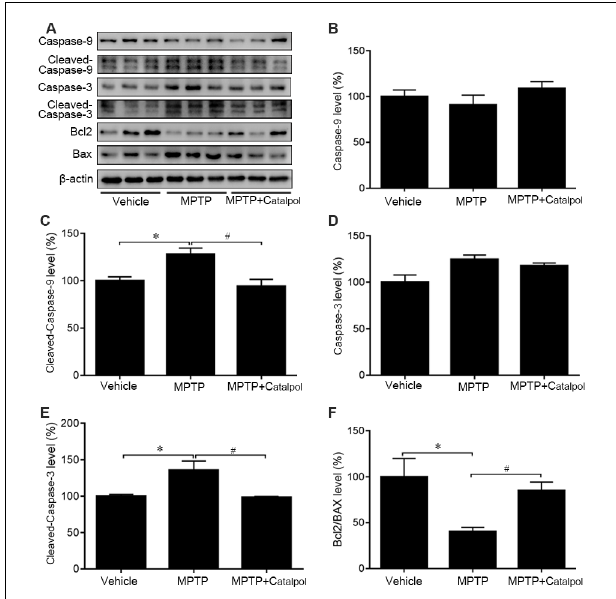
FIGURE 3 | Catalpol inhibits apoptosis in the SN of mice treated with MPTP. (A) Western blot analysis of caspase-9, cleaved caspase-9, caspase-3, cleaved caspase-3, Bcl2, and BAX levels in the SN. (B–F) Quantitative analysis of caspase-9, cleaved caspase-9, caspase-3, and cleaved caspase-3 levels and Bcl2/BAX ratio. Data represent mean ± SEM; n = 8 mice per group. The P -values were calculated using one-way ANOVA. ∗ P < 0.05 vs. vehicle group; # P < 0.05 vs. MPTP-induced